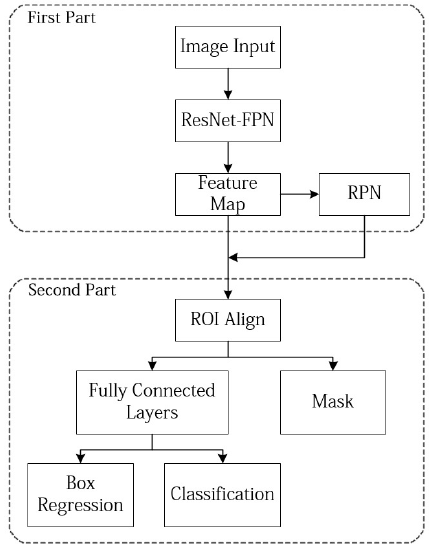
Figure 4. The flowchart of Mask